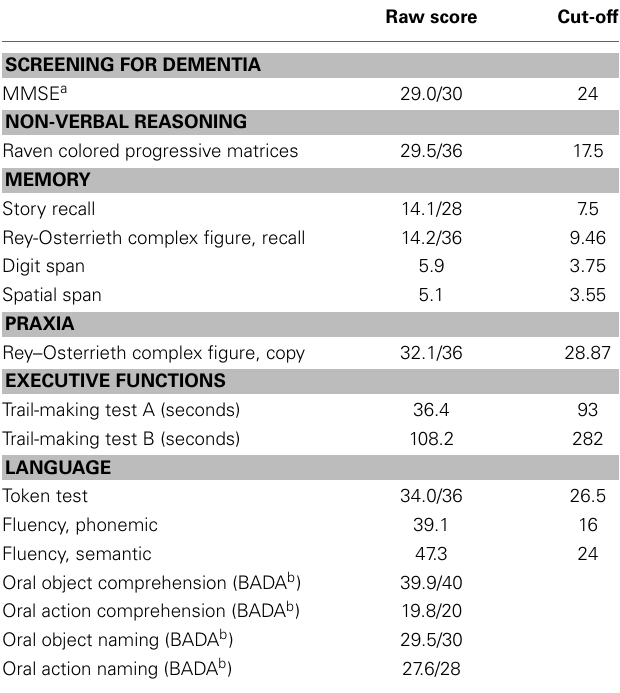
Table 1 | Neuropsychological data (mean) of the elderly